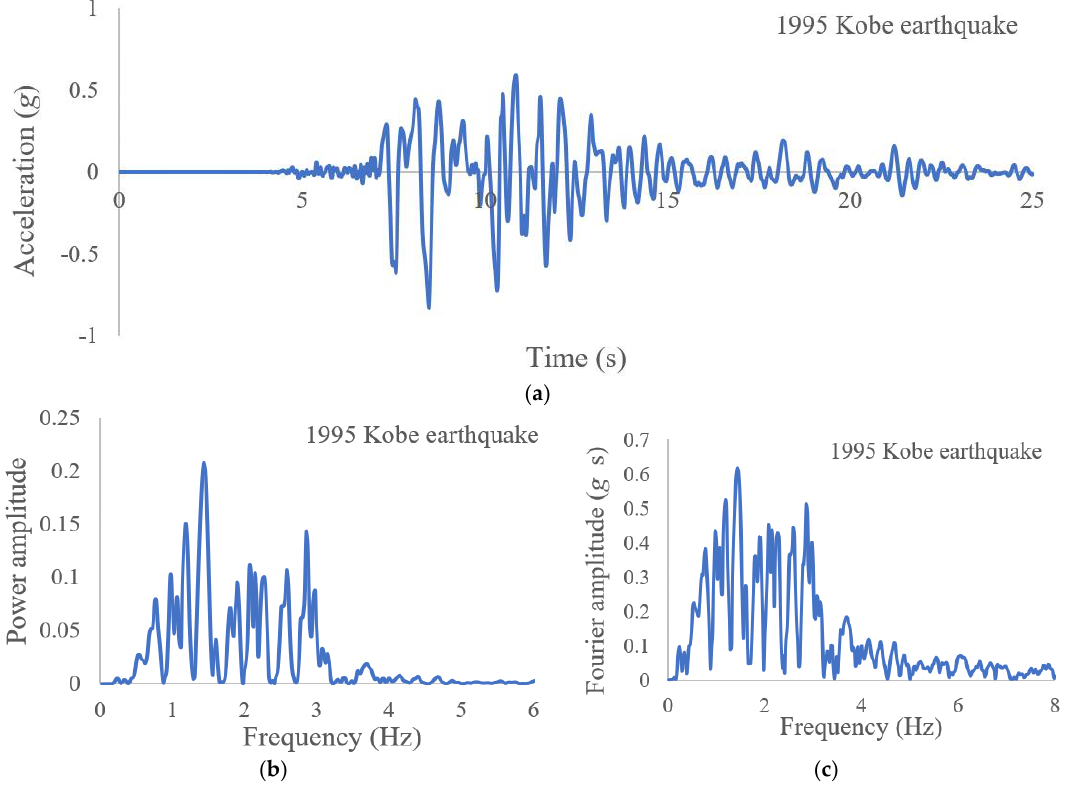
Figure 9. Characteristics of the 1995 Kobe earthquake: ( a ) the acceleration time history; ( b ) the power amplitude; ( c ) the Fourier amplitude spectrum.